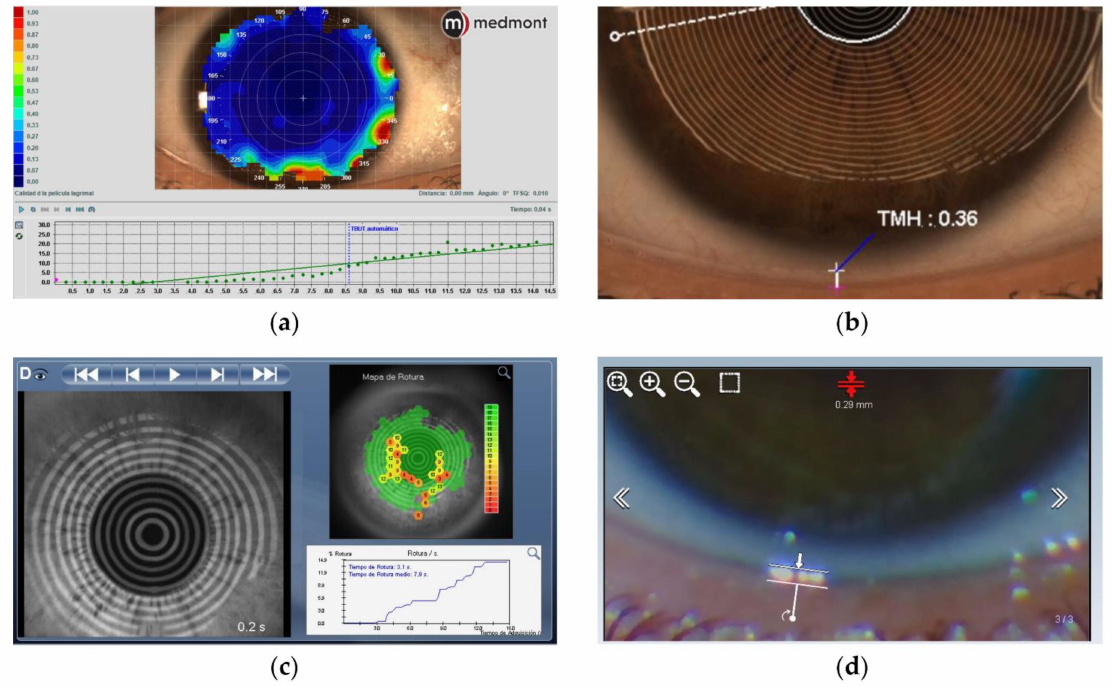
Figure 1. Display of the following measurements: ( a ) non-invasive tear break-up time (NIBUT) and ( b ) tear meniscus height (TMH) obtained with the Medmont E300; and ( c ) first NIBUT and 50%NIBUT and ( d ) TMH obtained with the Visionix